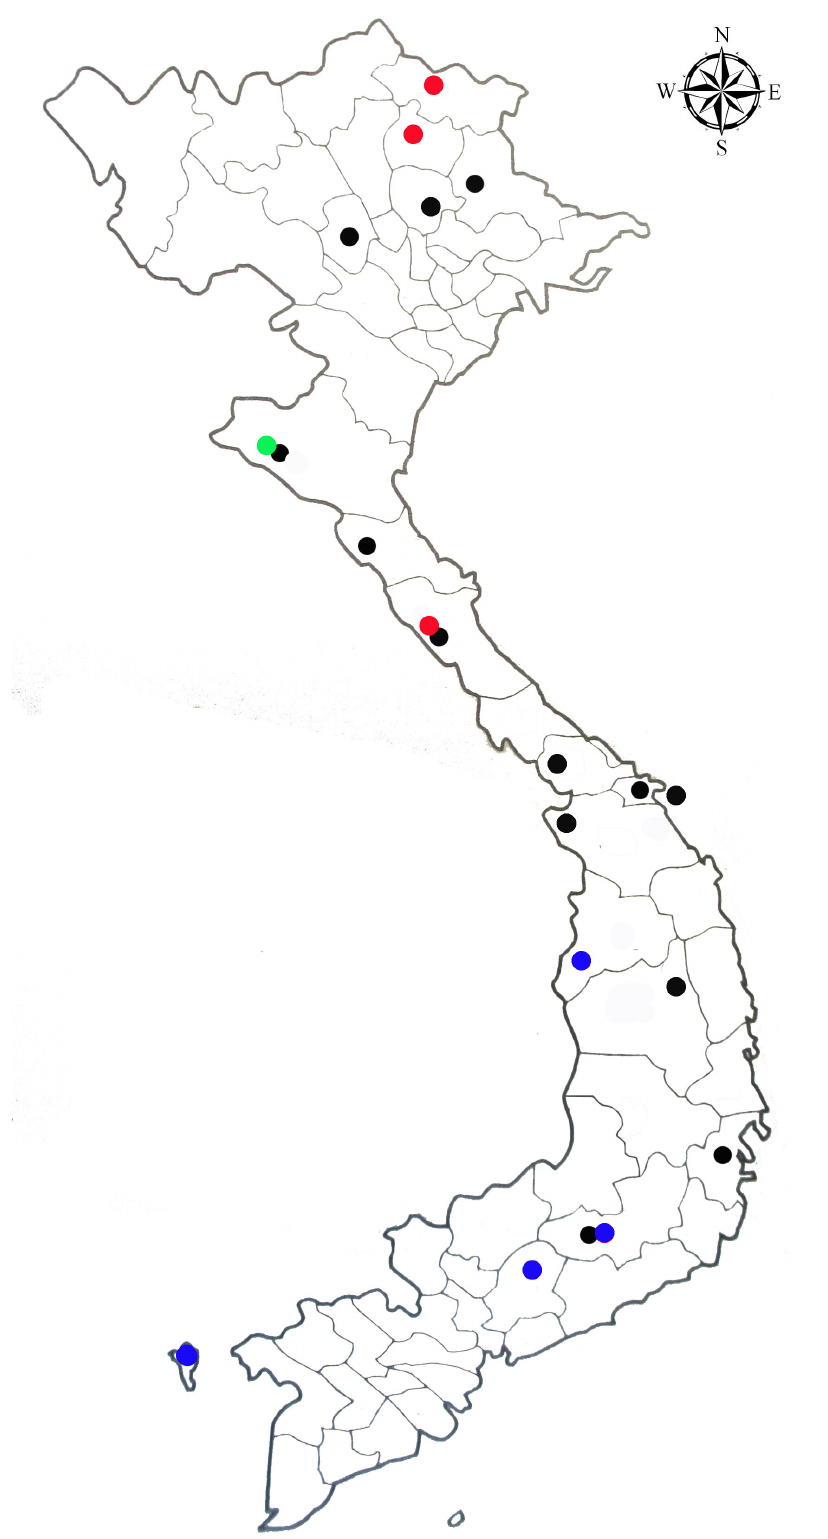
Fig. 18. Distribution map of Prodasineura Cowley, 1934 spp. in Vietnam (orange group species). (●) P. croconota Ris, 1916. (●) P. verticalis Selys, 1860. (●) Prodasineura kong sp. nov. (●) P. lancastrei sp.